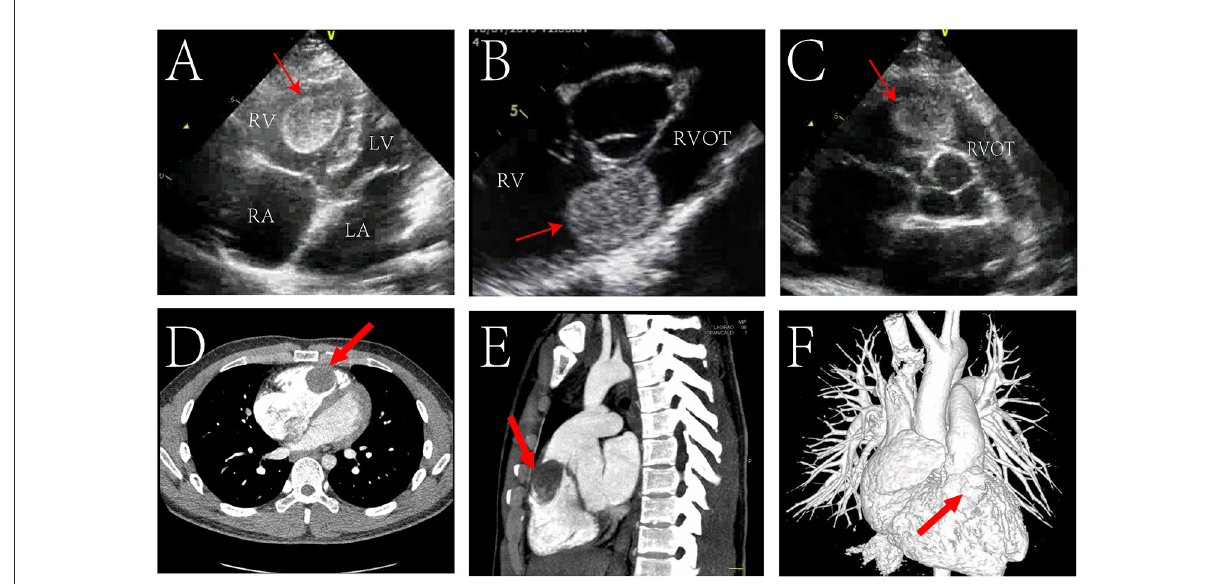
FIGURE1 Echocardiogram pre-operatively showing a mass (red arrow) located in the in the right ventricular outflow tract (RVOT) in transthoracic four chamber cross section (A) , transthoracic short axis section of aorta (B) , transesophageal short axis section of aorta (C) . Preoperative cardiac Computed Tomography (CT) showed a mass (red arrow) in the RVOT in transverse view (D) , sagittal view (E) ; CT angiography (CTA) showed a filling defect (red arrow) in the right ventricular outflow tract (F) . RV, right ventricle; LV, left ventricle; RA, right atrium; LA, left atrium.